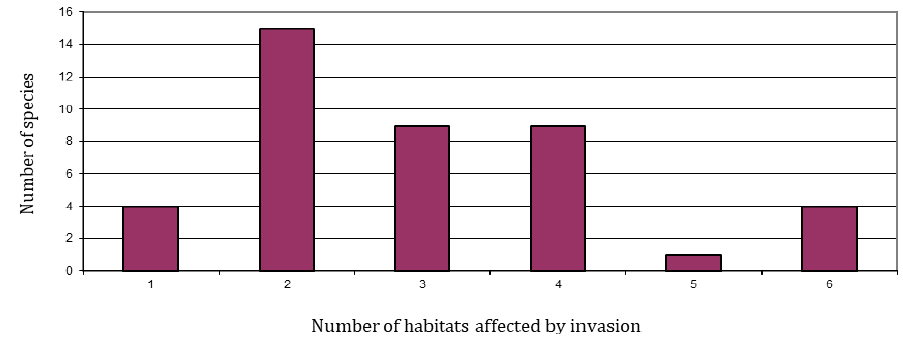
Fig. 3. Distribution of species into groups, depending on the number of invaded habitat types